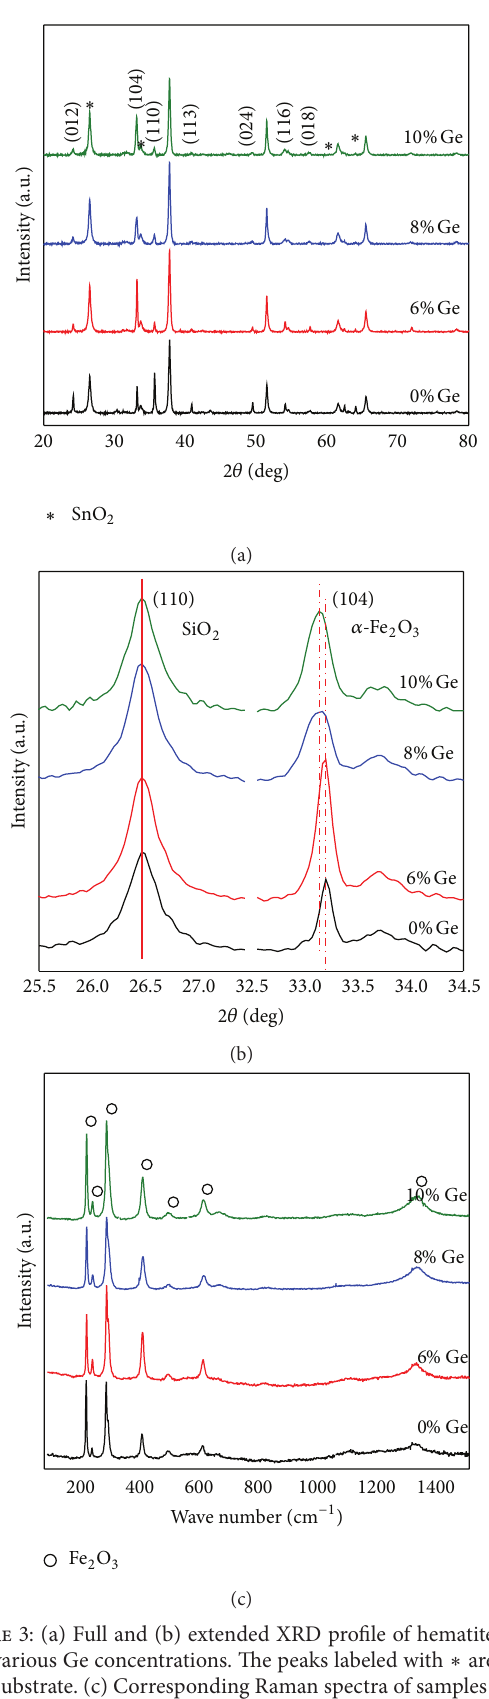
Figure 3: (a) Full and (b) extended XRD profile of hematite films with various Ge concentrations. The peaks labeled with ∗ are from FTO substrate. (c) Corresponding Raman spectra of samples in (a).